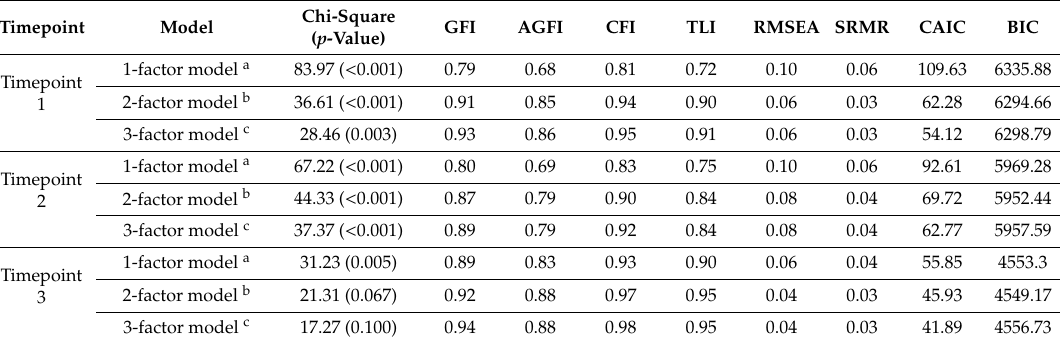
Table 4. Goodness-of-fit comparison of